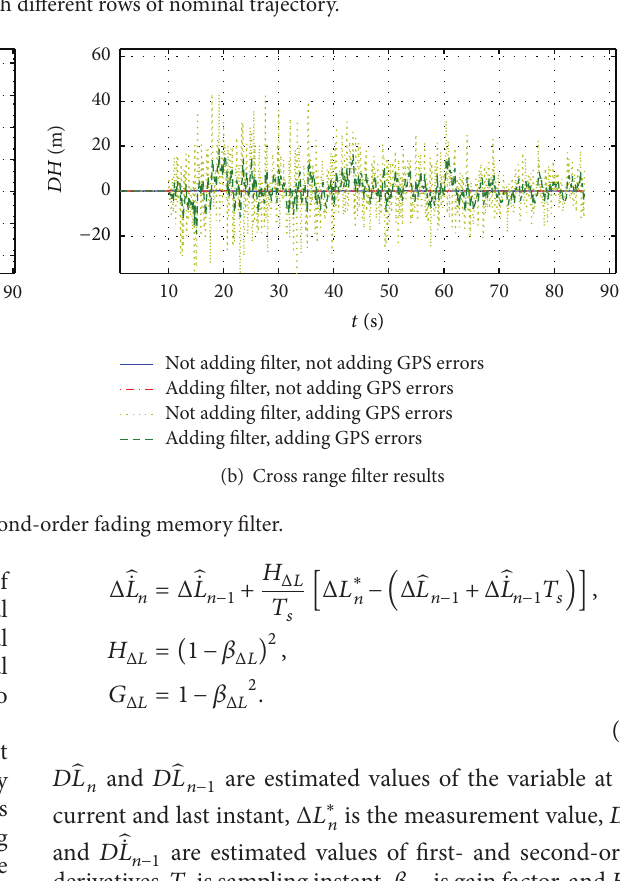
Figure 9: Predictive results with different rows of nominal trajectory.